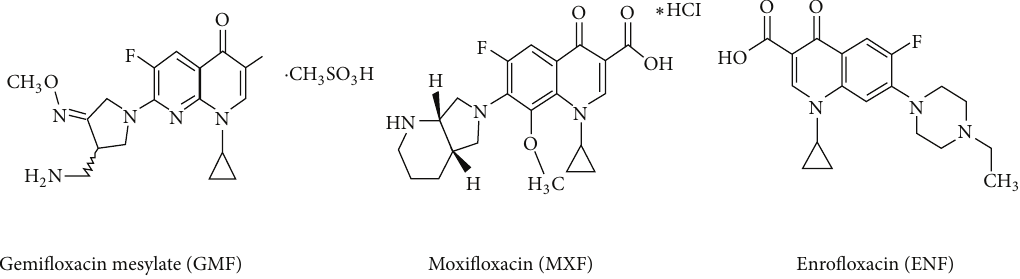
Scheme 1: The chemical structure of the studied